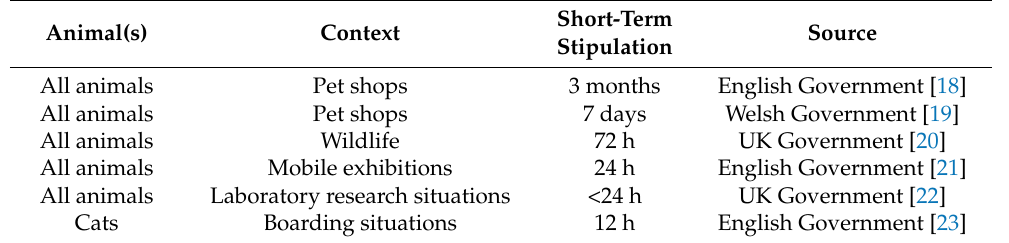
Table 1. Short-term (including ‘temporary’ or ‘transitional’) confinement for animals: UK Government legislation or guidance.